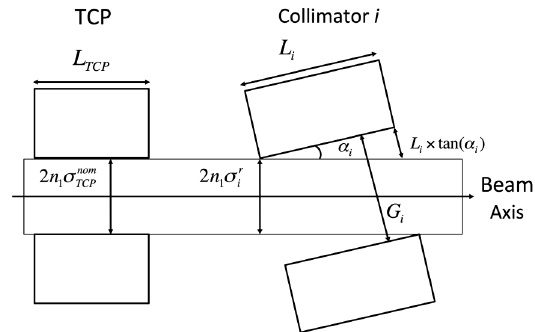
FIG. 5. Schematic of the position of the jaws of a collimator i misaligned by an angle (cid:6) i , which introduces an error in the measured gap [21]. The reference primary collimator is assumed to be perfectly